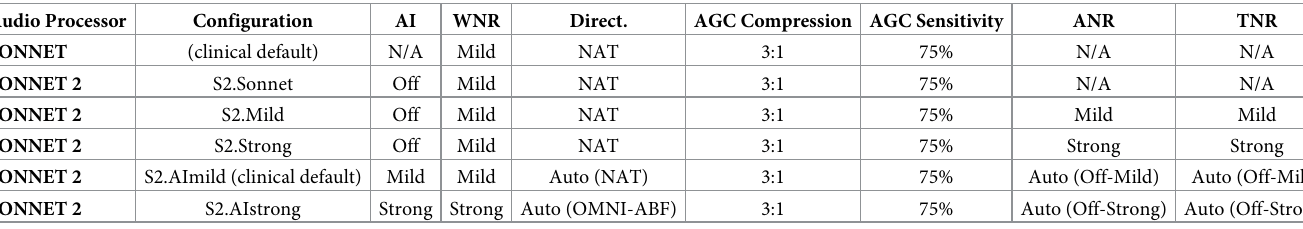
Table 2. Audio processors and tested audio processor